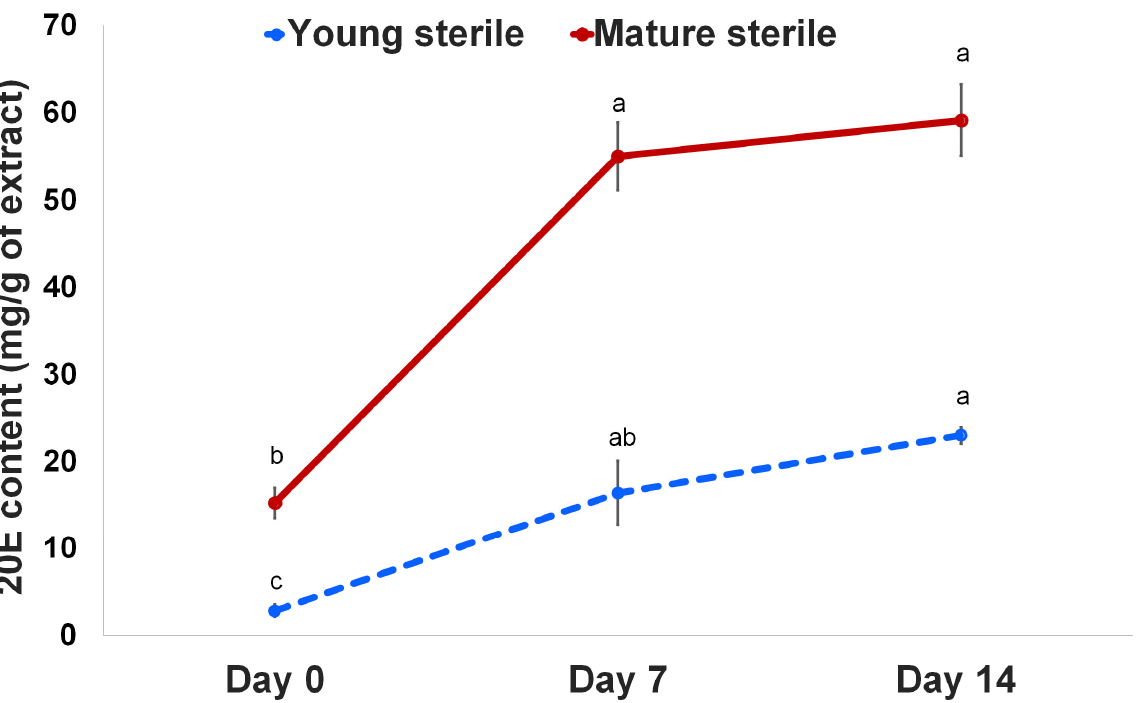
Figure 2. 20-hydroxyecdysone (20E) content in young and mature sterile fronds of M. scolopendria after treatment with 50 mg/mL chitosan at 7 DAT and 14 DAT, respectively. Values within a row followed by the same superscript letter(s) are not significantly different at p ≤ 0.05 based on Duncan’s multiple range test.